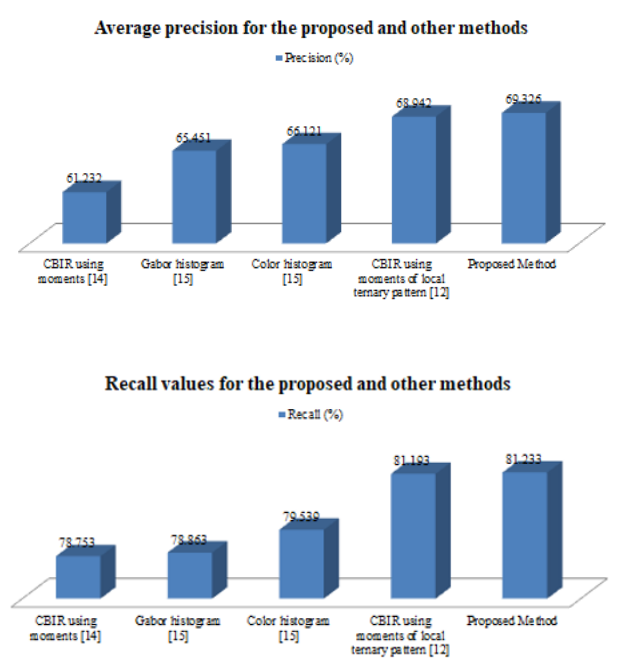
Figure 3 . The grap present the average precision and recall values for the proposed and other